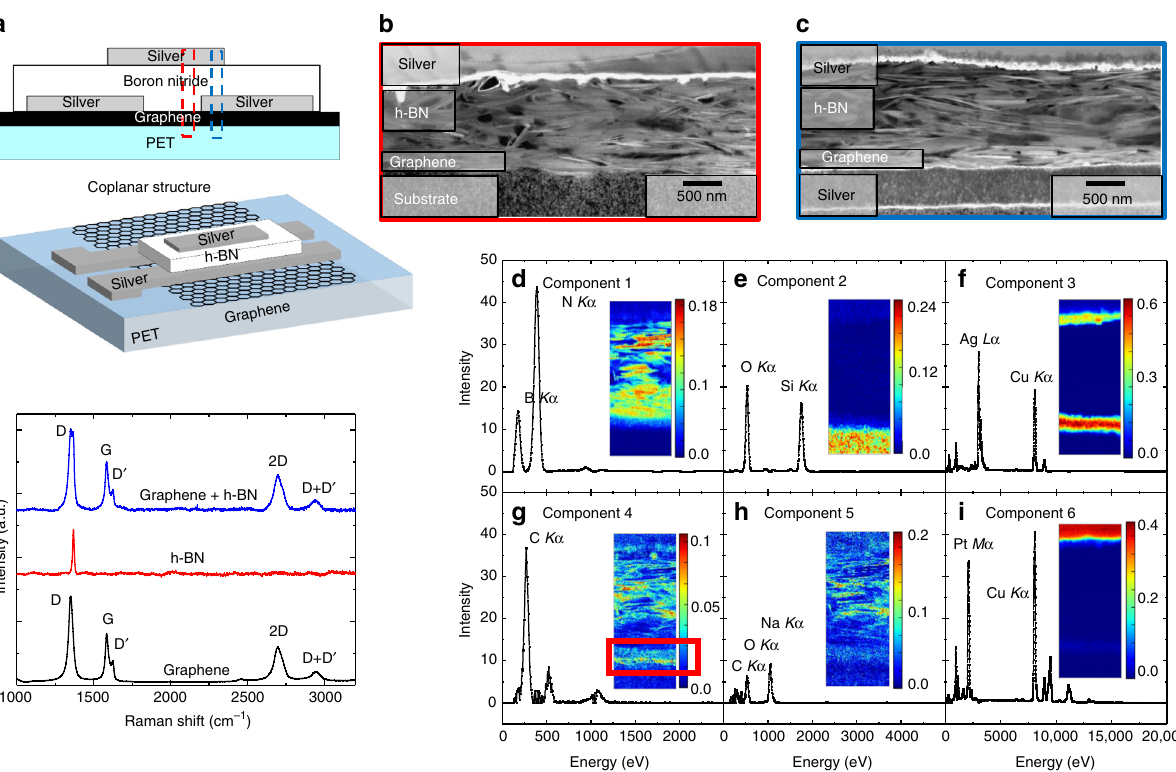
Fig. 2 Inkjet-printed coplanar FET on PET. a Schematic of a printed coplanar FET heterostructure. HAADF-STEM cross-sectional view of the regions in the red dashed line ( b ) and blue dashed line ( c ). Multivariate analysis of the cross section in the blue region showing non-negative matrix factorization loadings and factors (insets) ( d – i ). The red box in g indicates the presence of the carbon (i.e. graphene) fi lm. j Raman Spectroscopy of the printed coplanar FET